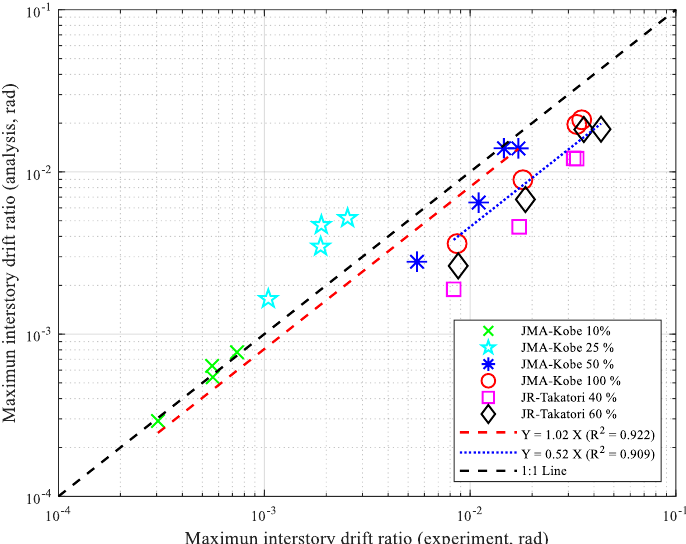
Figure 10. Comparison between maximum inter-story drift ratio obtained from experiments and analyses on log–log plot.